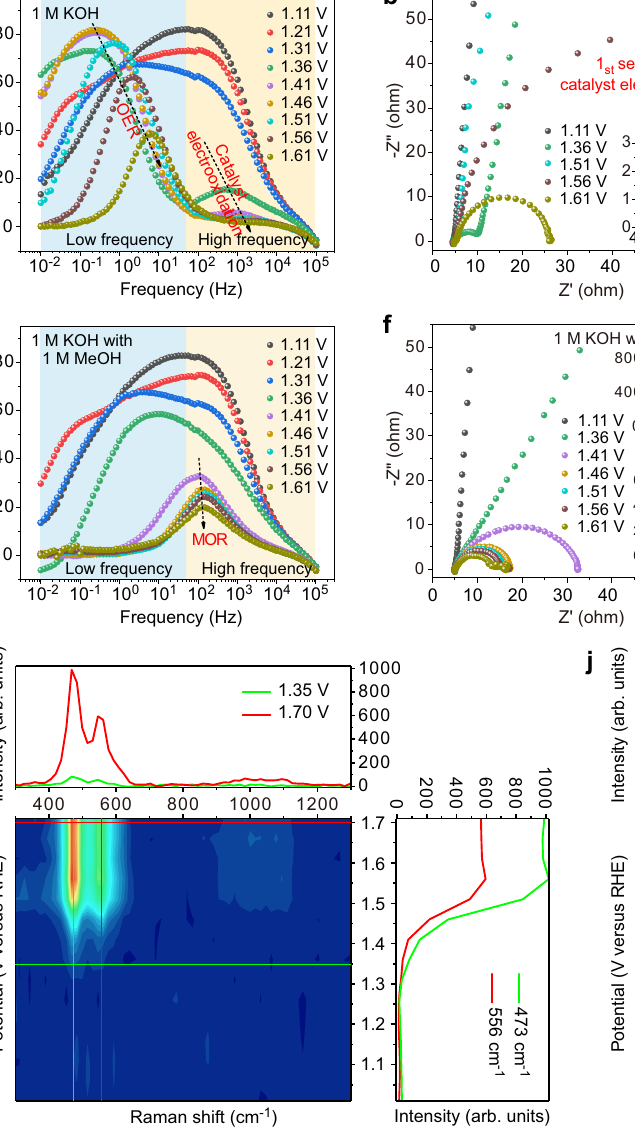
400 for MOR in different potentials. g Equivalent circuit models for MOR. h Correlation of the equivalent resistance and potentials for NiB-400 during MOR. In situ Ramanspectraof NiB-400 in OER i and in MOR j processes. Source data are provided as a Source Data fi